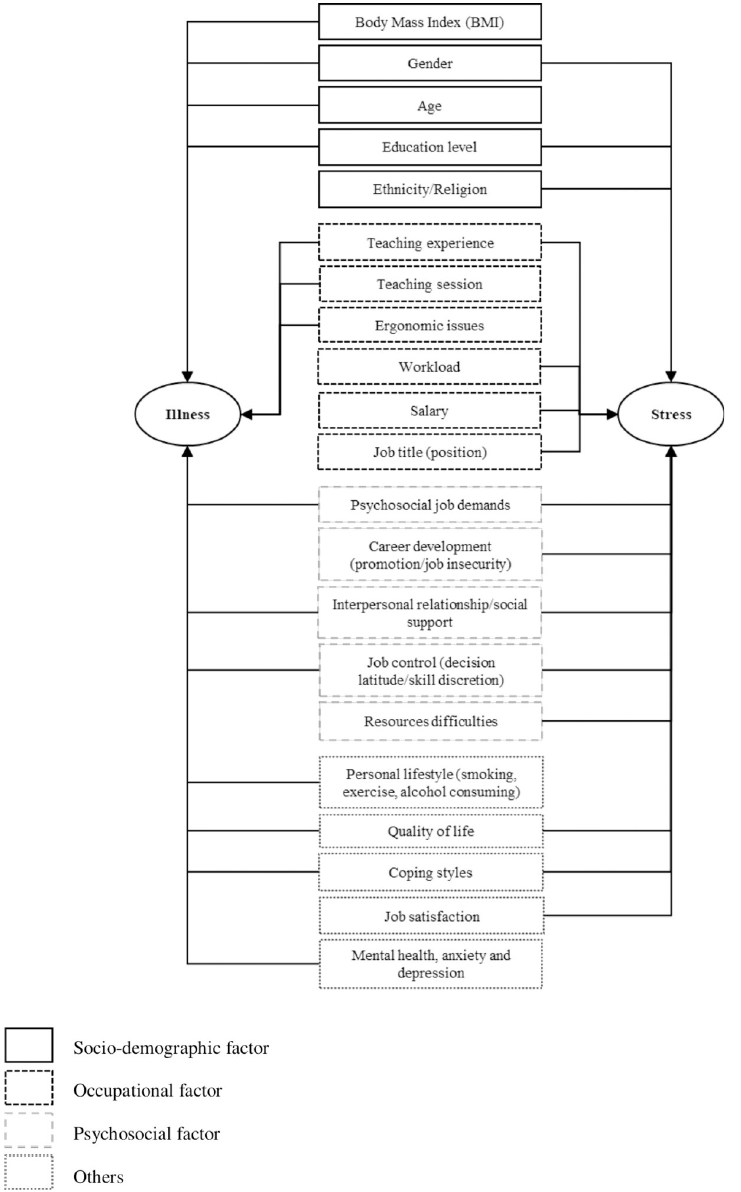
Fig 3. Associated risk factors of illness and